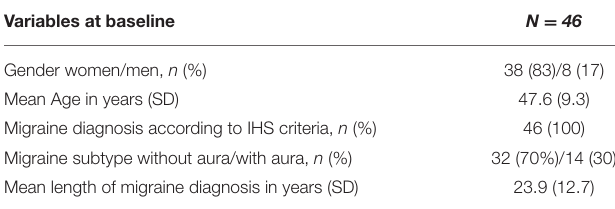
TABLE 1 | Table of demography — patient characteristics at baseline. Variables at